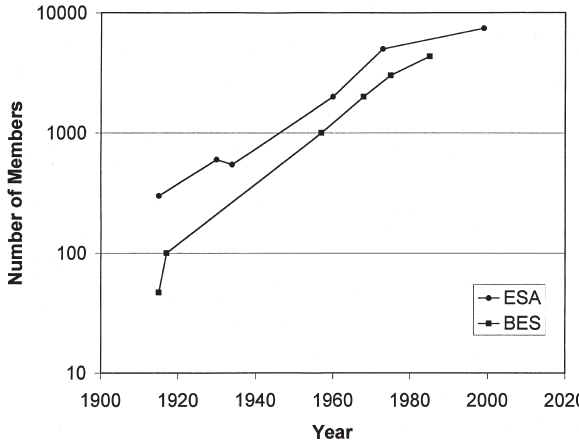
Fig. 2. – Growth in membership of the British Ecological Society, as compared to the Ecological Society of America. ESA is indicat- ed by solid circles and BES by open circles. Note the change in number from the mid1970’s to the present for